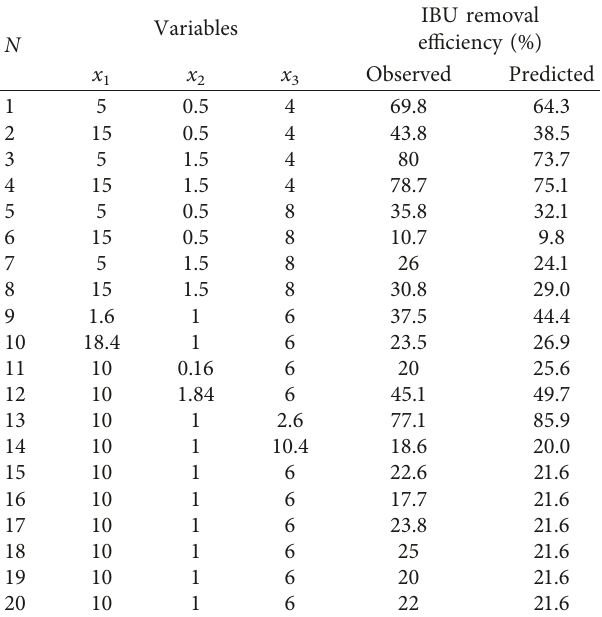
Table 3: Experimental design used for investigation of IBU re- moval over